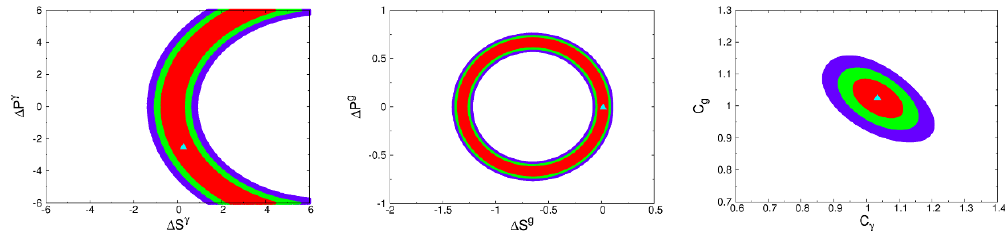
Figure 13 . CPV3 : the con(cid:12)dence-level regions of the (cid:12)t by varying C S code is the same as in (cid:12)gure 2.